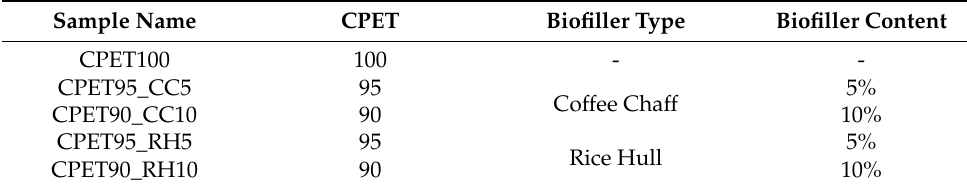
Table 1. CPET/biofiller blends formulation in terms of weight percentage.